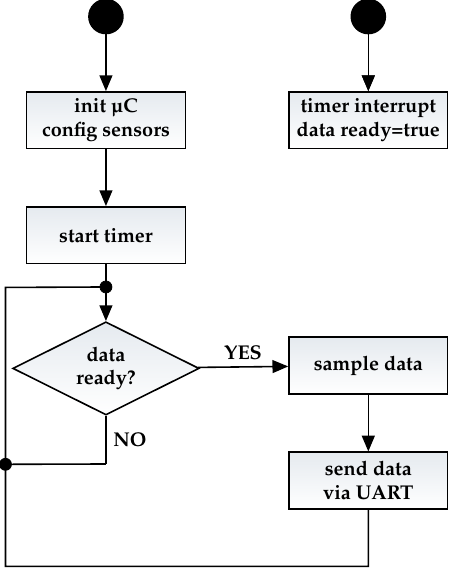
Figure 3. Flow chart of the example firmware implementation.